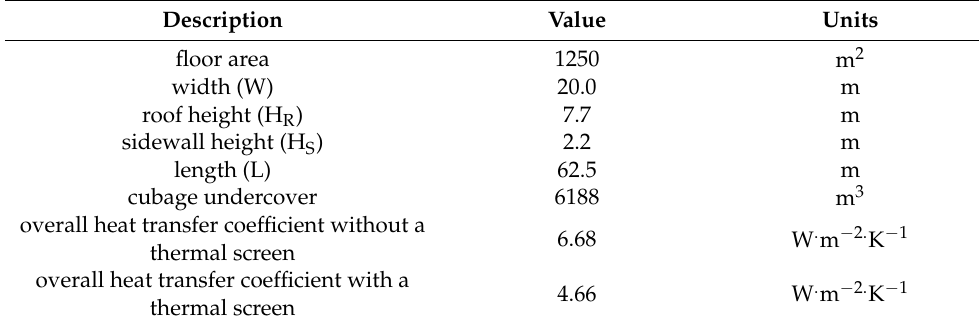
Table 1. Characteristics of the GH under study.